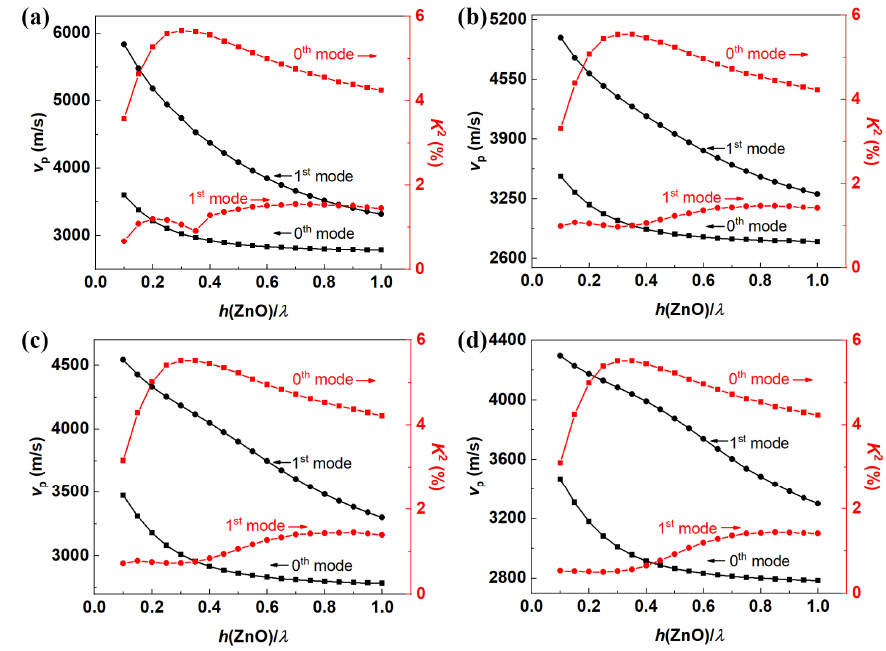
Figure 5. v p and K 2 of Love-mode waves as functions of h (ZnO) in the SAW devices based on the a-ZnO/a-GaN/r-sapphire structure with h (GaN) of 0.25 λ ( a ), 0.5 λ ( b ), 0.75 λ ( c ) and 1.0 λ ( d ).